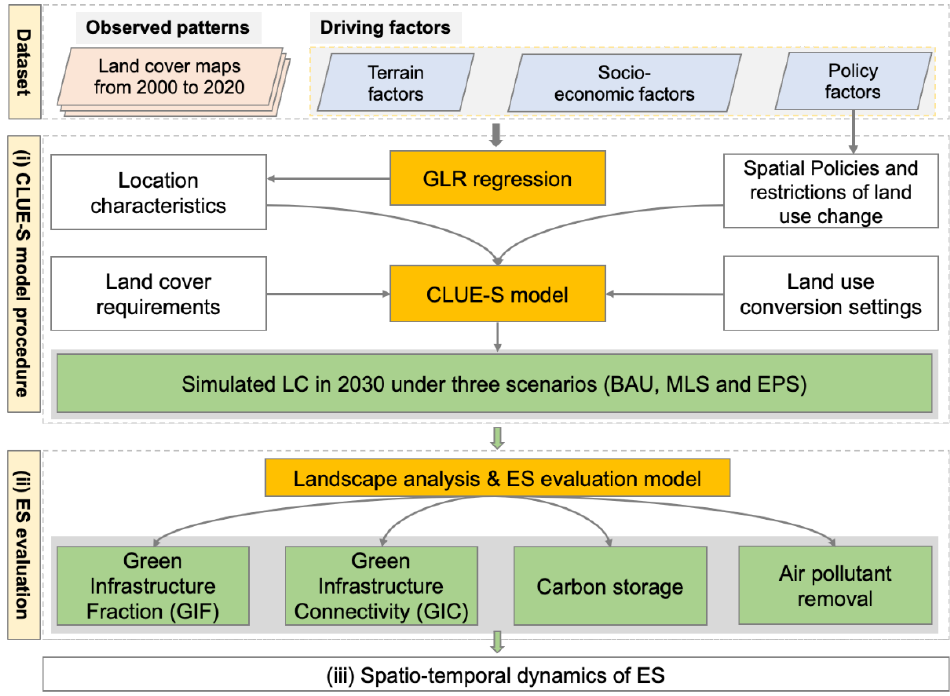
Figure 2. Framework from past to future for ES evaluation (BAU = business-as-usual scenario; MLS = market-liberal scenario; EPS = ecosystem protection scenario).